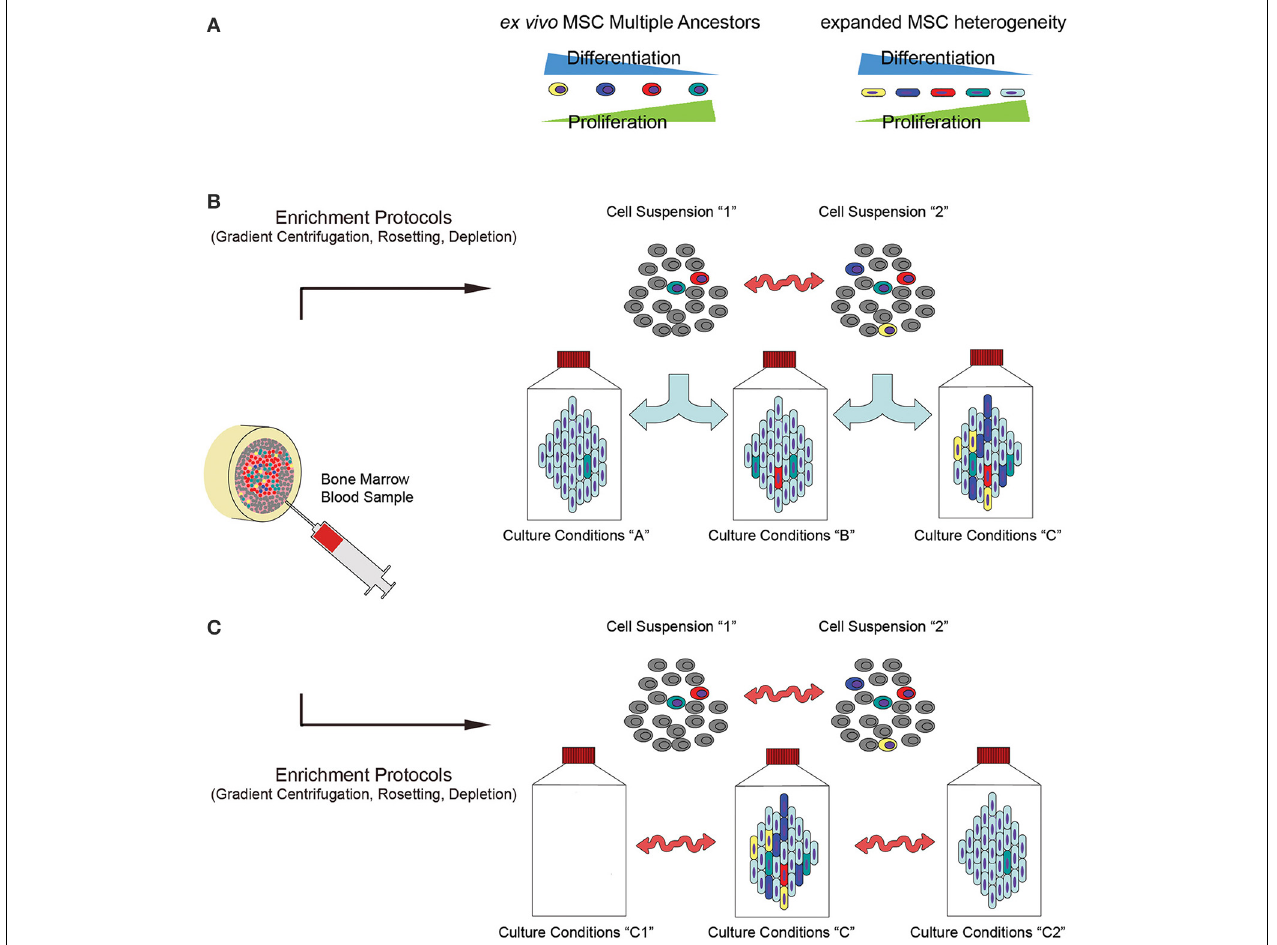
FIGURE 2 | Influence of culture determinants and stochastic events on the biology of bone-marrow-derived MSCs. (A) Recent hypotheses suggest that MSCs may be derived from different progenitors that vary in terms of proliferative/differentiative ability and functionality, thus contributing to a high level of heterogeneity detected among the cell populations in the final products. Due to the presence of multiple ex vivo MSC progenitors, (B) different enrichment methods donor variability could lead to significantly different cell populations in terms of percentage of these various ancestors (indicated as “Cell Suspension 1” and “Cell